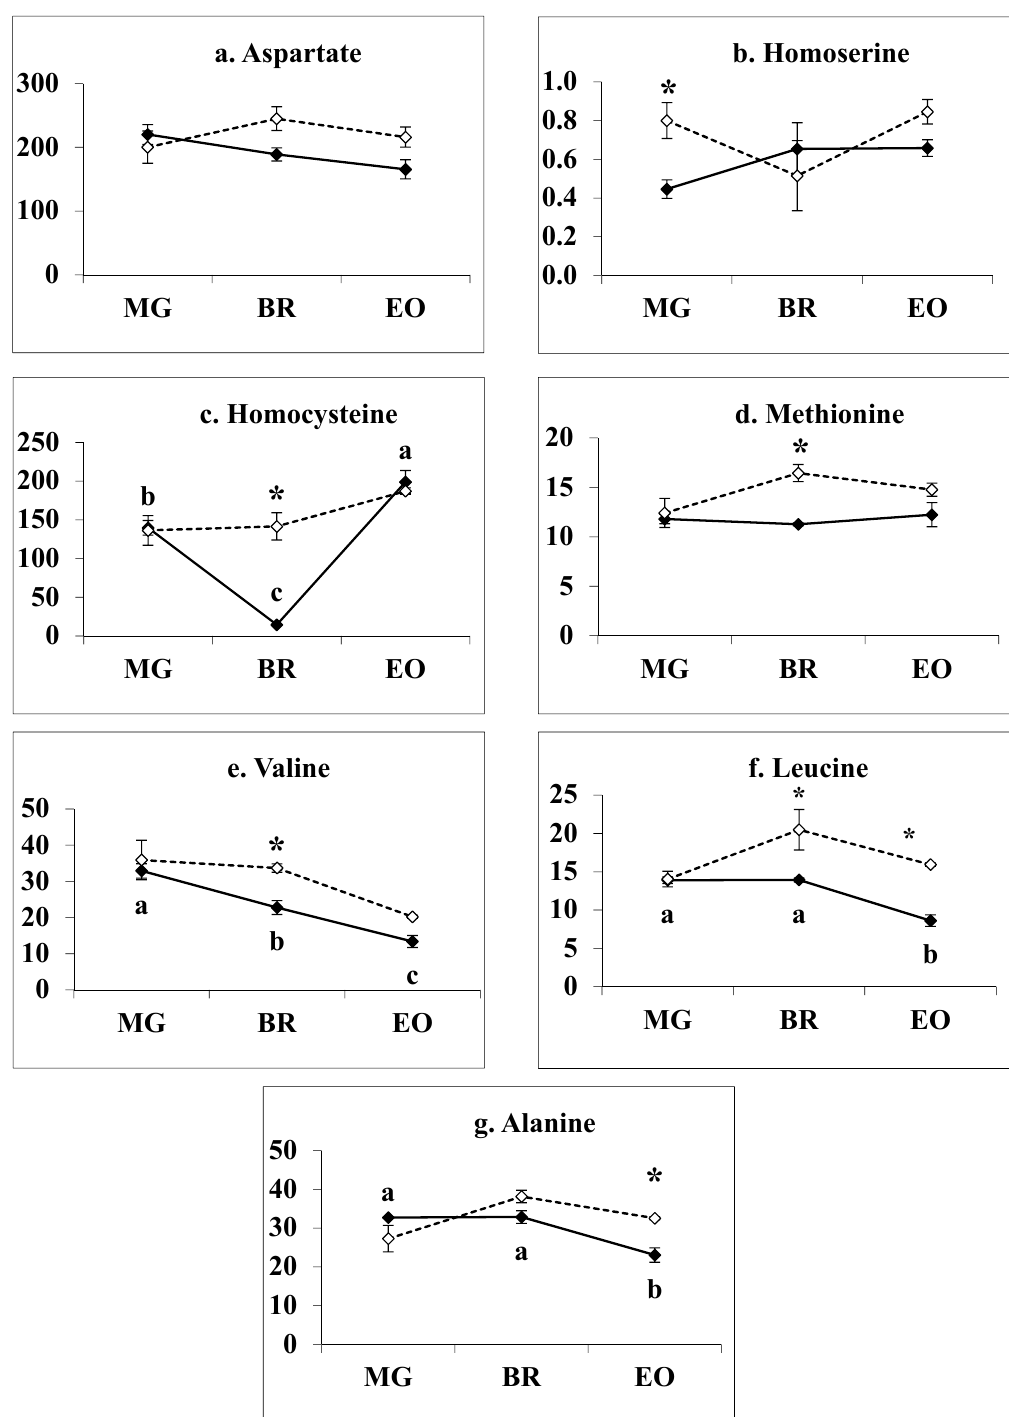
Figure 7. Intermediate metabolites and free amino acids (nmol gFW − 1 ) in ripening tomatoes, treated or untreated with 1-MCP. ( a ) aspartate, ( b ) homoserine, ( c ) homocysteine, ( d ) methionine, ( e ) valine, ( f ) leucine, and ( g ) alanine. The broken line represents the 1-MCP treated fruit and the full line represents the control fruit. MG—mature green, BR—breaker, EO—early orange. Values are mean ± SE bars (for control samples n = 3, for 1-MCP samples n = 2). ( a – c ) di ff erent letters represent significant di ff erences between the ripening stages of the same treatment at p < 0.05 (Tukey HSD). * Asterisk represents significant di ff erence between treatments at the same ripening stage at p < 0.05 (Student t -test). Letters / Asterisk were not added if there were no statistical di ff